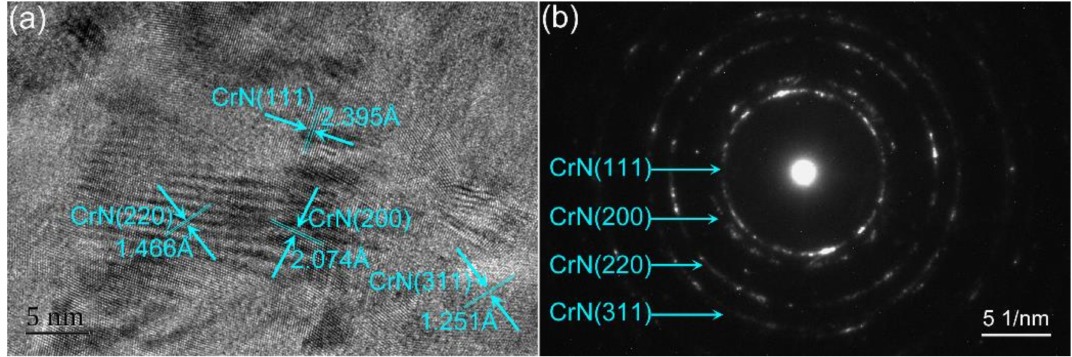
Figure 4. ( a ) Surface HRTEM result of the T130 thin film. ( b ) The corresponding SAED pattern of surface lattice